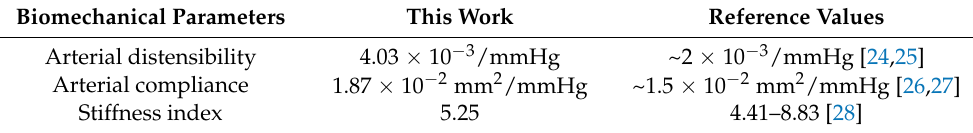
Table 2. Biomechanical parameters extracted from artery diameter change and blood pressure. Biomechanical Parameters